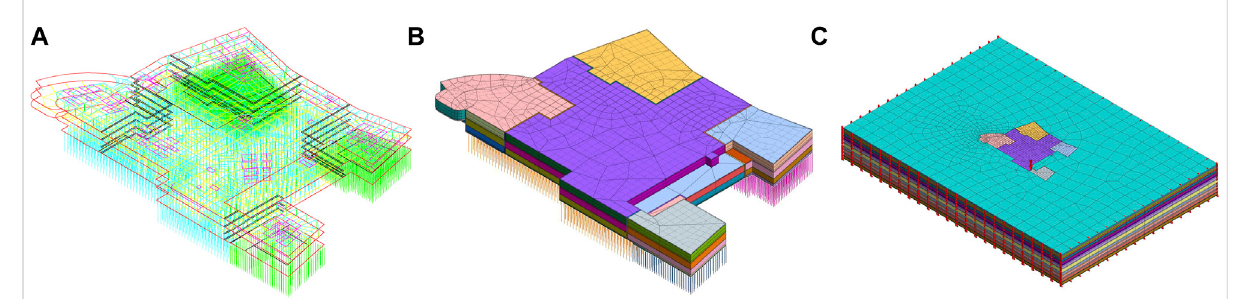
FIGURE 4 Finiteelementmodeling: (A) Singlelineplanofundergroundstructure; (B) Meshing oftheundergroundstructure; (C) Buildinganoverall model.